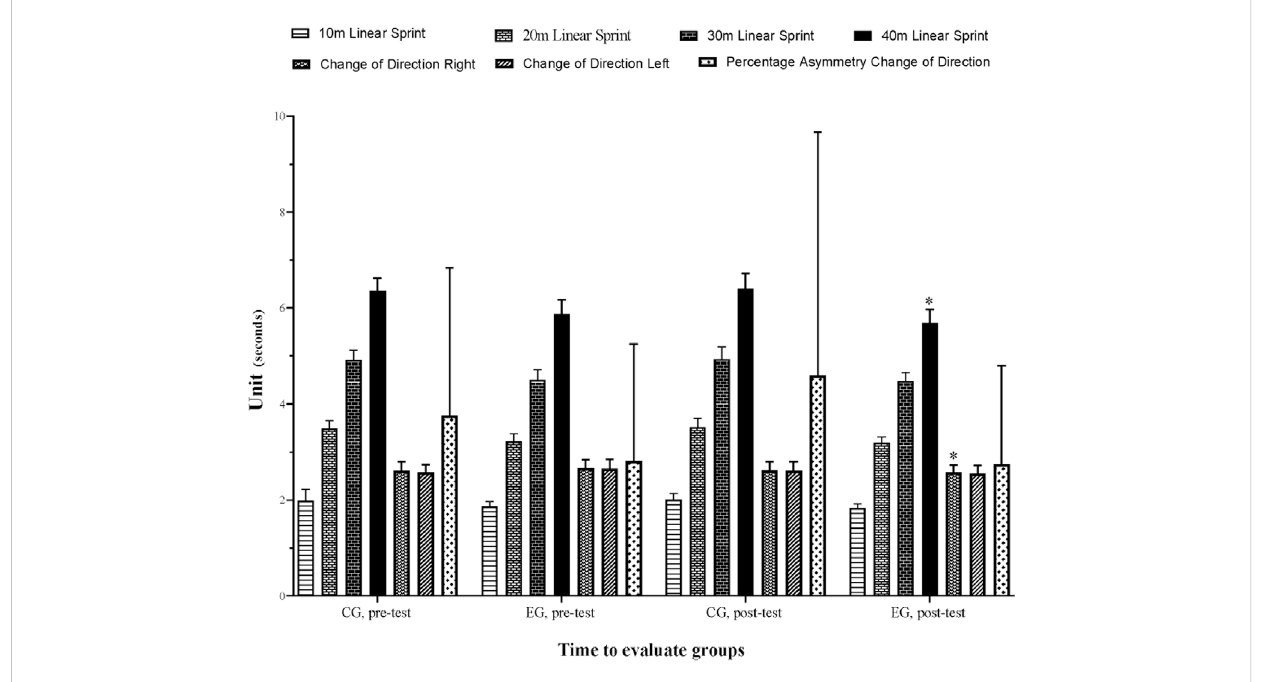
FIGURE 4 Variation in sprint and change of direction variables for control and experimental